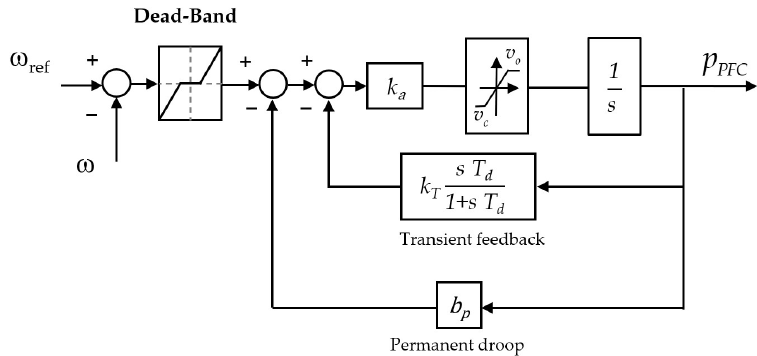
Figure 4. Control scheme of the HG2 model.